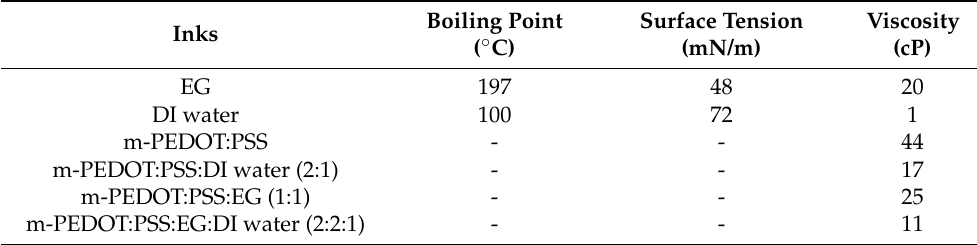
Figure 1. The sheet resistance of PEDOT:PSS films with different ink formulations (inset: the contact angle and film image of pristine PEDOT:PSS, PEDOT:PSS added DMSO, and PEDOT:PSS added DMSO and Triton X-100 on the glass substrates, respectively). Table 1. Boiling point, surface tension, and viscosity of the solvents and PEDOT:PSS inks with various